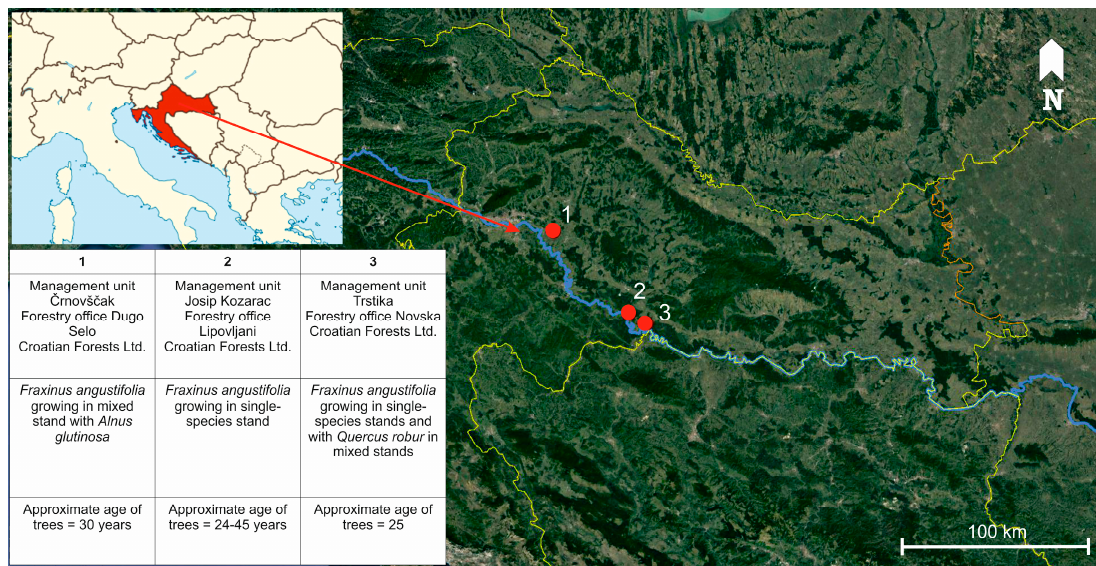
Figure 1. Map of three sampling locations in lowland forests at the Sava river basin.